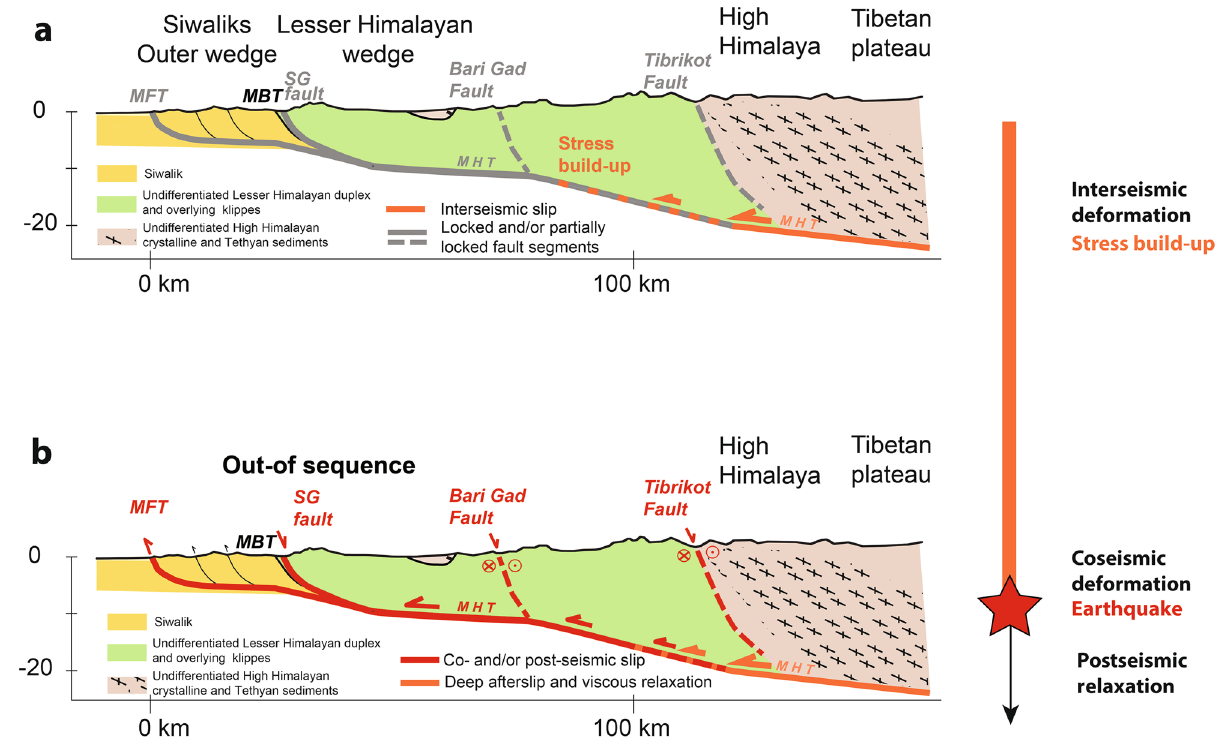
Figure 9. East–West tectonic sketches of the Main Himalayan fault system (see Fig. 1 for location). Figure generated with Adobe illustrator CS6 (http:// www. adobe. com/ fr/ produ cts/ illus trator.